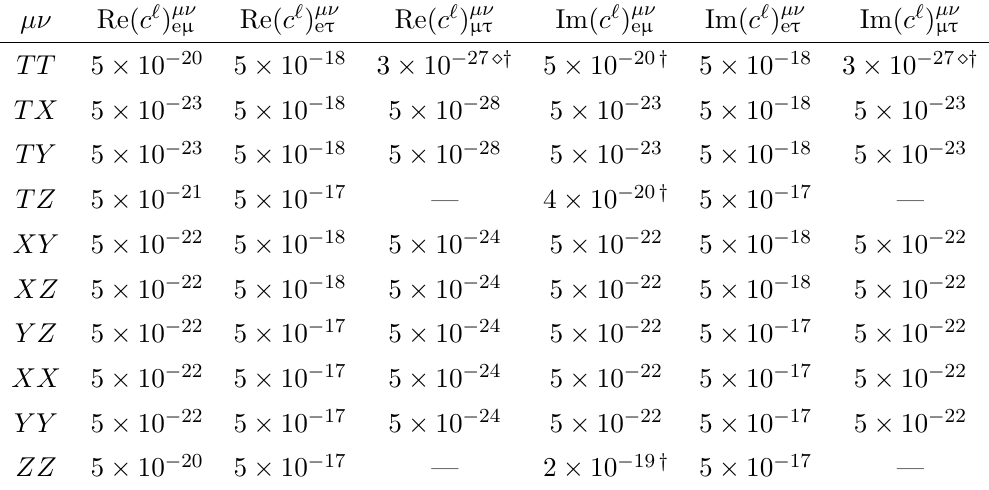
Table 2 . The same as table 1, but for the dim-4 two-tensor coefficients ( c ‘ ) µν We assumed that the right-handed charged-lepton fields remain unmodified: ( c R ) µν unstated sensitivities to ( d ‘ ) µν be multiplied by 2, whereas no bounds can be inferred on ( d ‘ ) µν used from table D30 of ref.